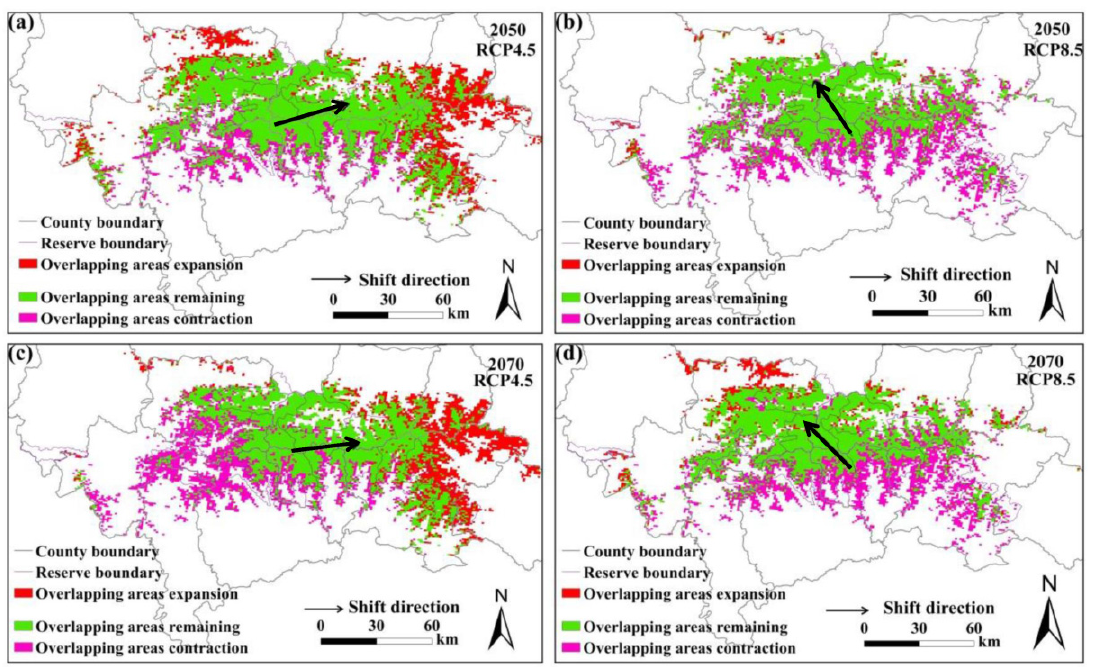
Figure 3. Overlapping suitable habitats of giant pandas and golden takins under different climate change scenarios. ( a , b ) represent the changes under the RCP4.5 and RCP8.5 scenarios in 2050s, respectively; ( c , d ) represent the changes under the RCP4.5 and RCP8.5 scenarios in 2070s, respectively.